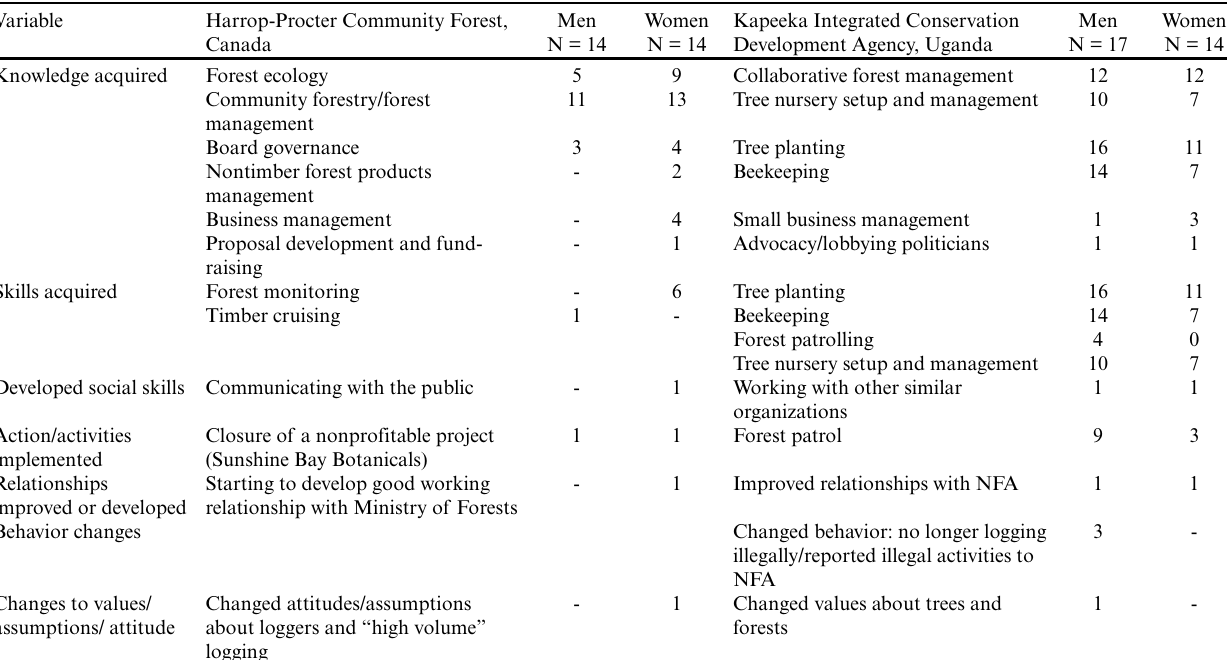
Table 3 . What interviewees reported learning during forest